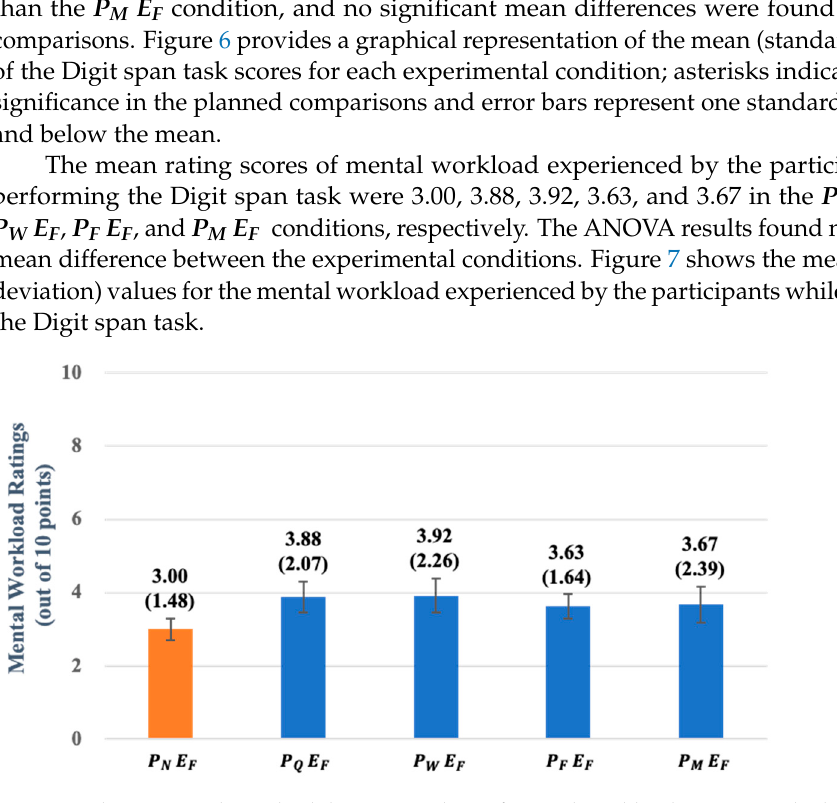
Table 2. The mean and standard deviation values of all dependent variables for each experimental condition in Experiment 2 .